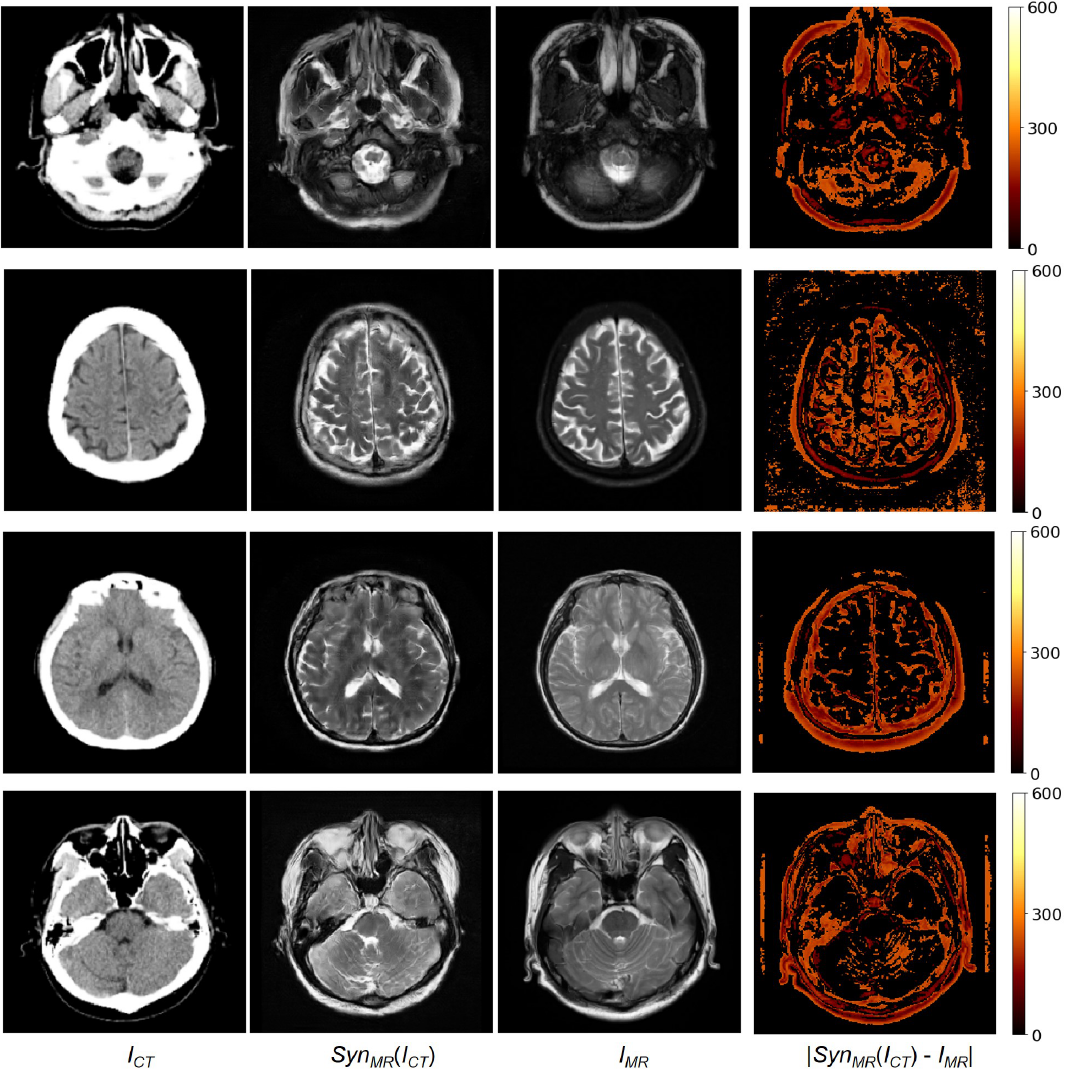
Figure 5. From ( left ) to ( right ): Input CT, synthesized MR, reference MR, and absolute error between reference and synthesized MR